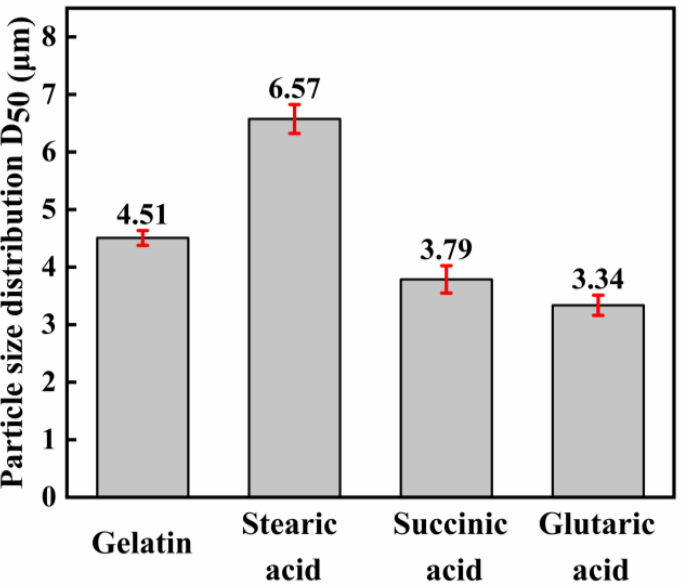
Figure 6. Variation of the average size of silver particles (D 50 ) with different dispersants.